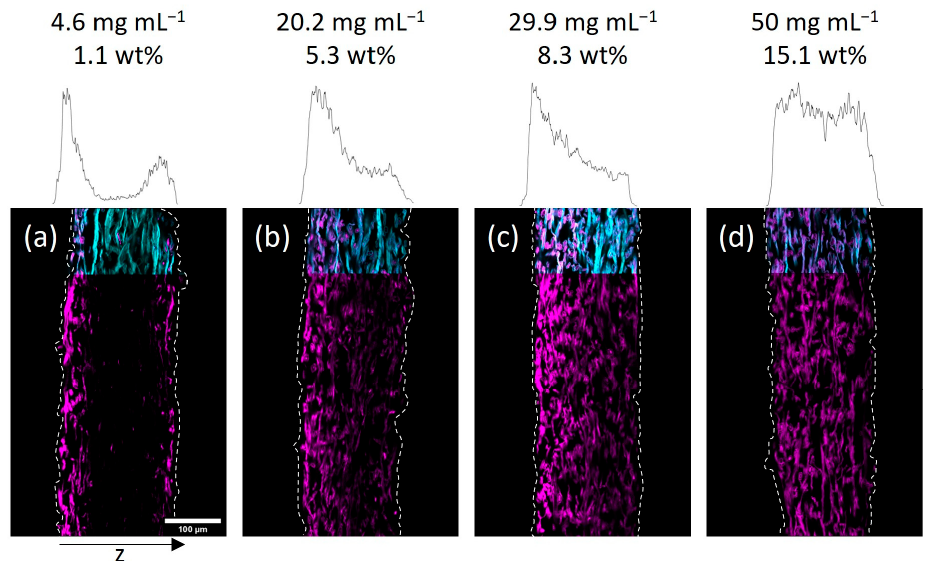
Figure 3. Cross-sections of paper samples modified with the photo-cross-linkable copolymer dissolved in H 2 O at different concentrations as indicated, acquired by fluorescence CLSM. The fibers are stained with Fluorescent Brightener 28 (FB, cyan color) and the copolymer fluoresces due to the rhodamine B label (magenta). The left side of the images corresponds to the side that was facing upwards during the drying and UV-excitation of samples. The z-distribution of the copolymer fluorescence is shown above each cross-section. For easier comparison, the corresponding concentrations of polymer solutions and the gravimetrically determined amount of copolymer are also noted: 4.6 mg mL − 1 , 1.1 wt% ( a );